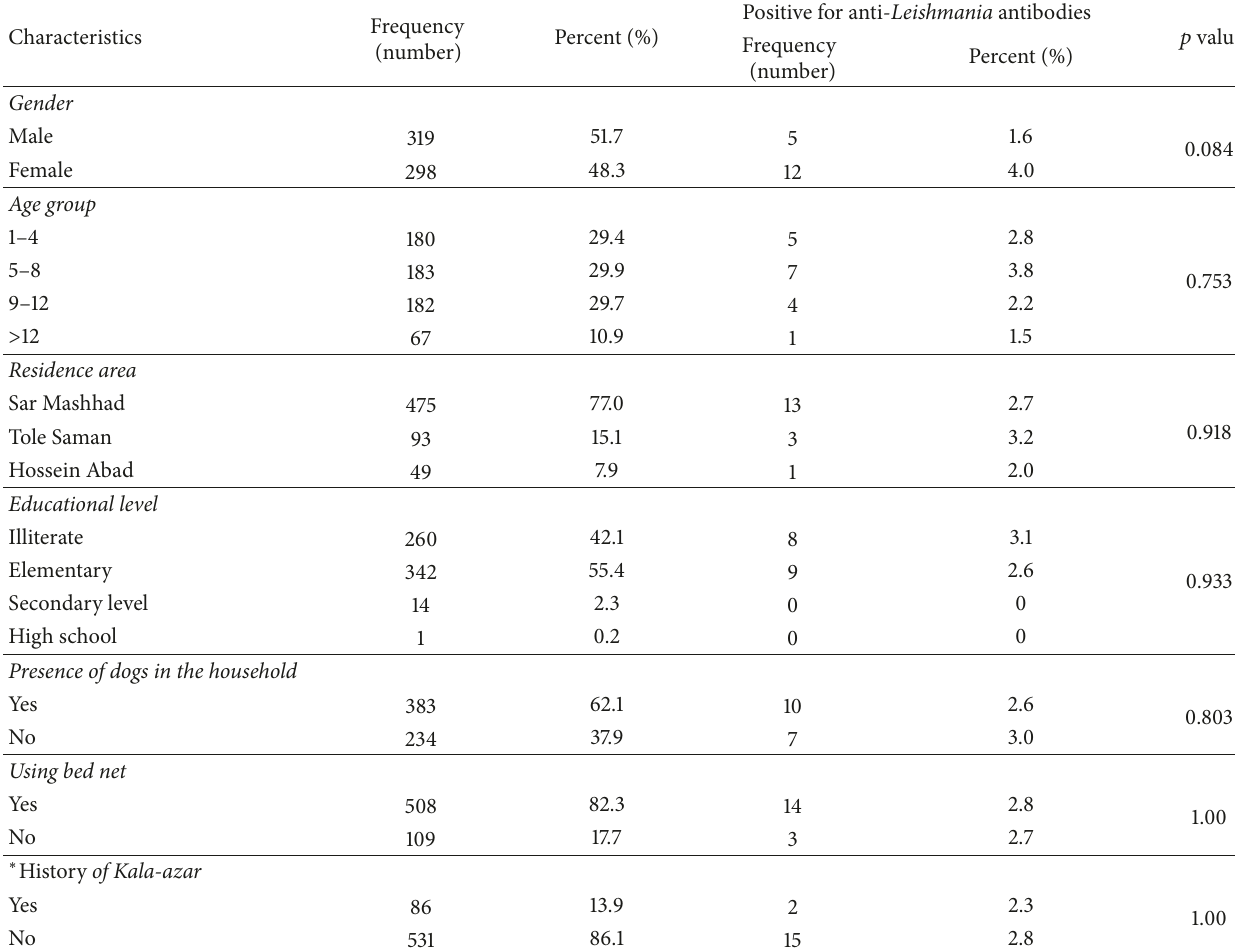
Table 1: Sociodemographic characteristics of children and relative seropositivity to L. infantum in Sar Mashhad district, Southern